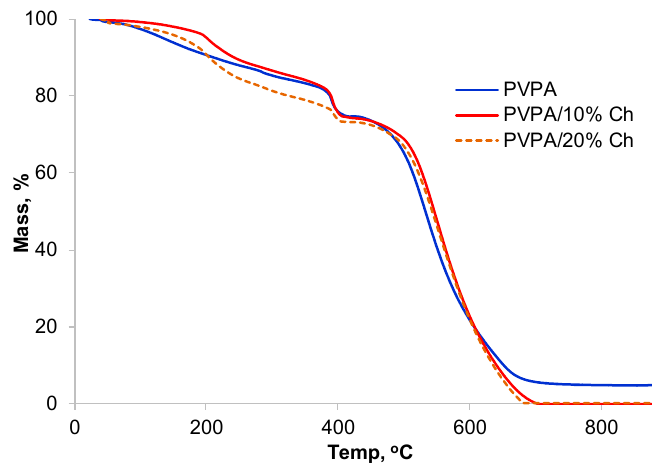
Figure 12. TGA curves for PVPA and chitosan containing plaques under air, with a heating rate of 10 °C per minute from RT to 900 °C.